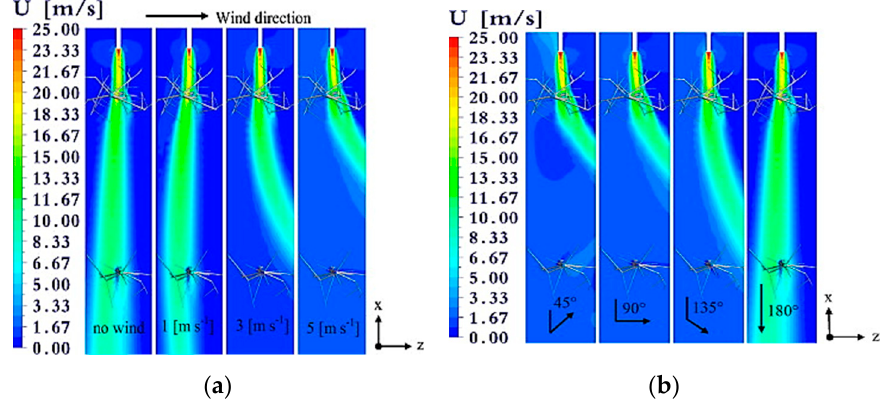
Figure 5. Effect of wind speed ( a ) and direction ( b ) in spraying using CFD analysis [149] (used with permission).